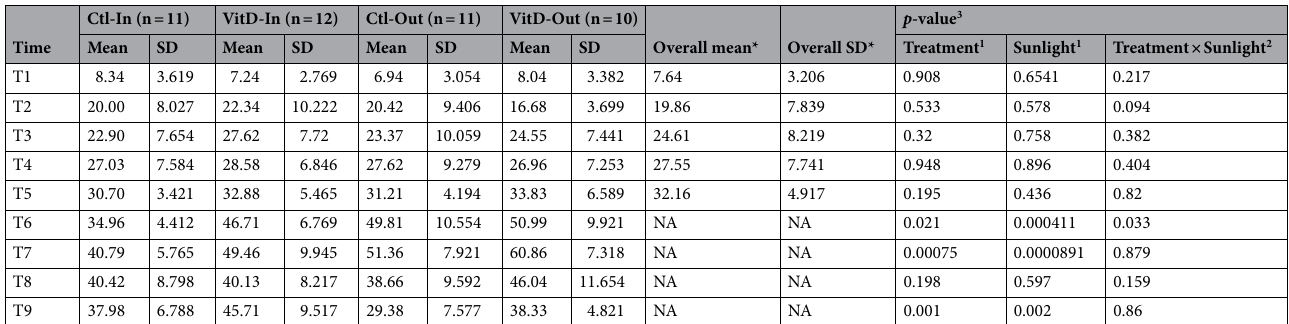
Table 1. Serum 25OHD concentrations (ng/ml) within each group for all time points assessed. *When no statistical difference was observed between treatments, an overall mean and SD was obtained for all groups, NA not applicable, n number of animals. 1 Main effects of treatment and sunlight. 2 Interaction between treatment and sunlight. 3 Interaction among treatment, sunlight and time was significant ( p <